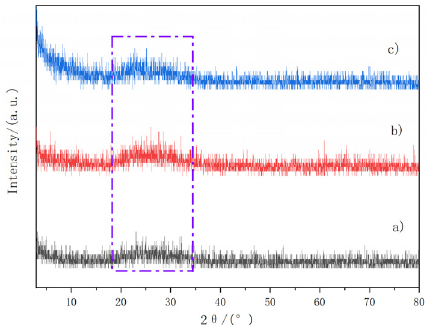
Figure 8. XRD patterns of basalt fiber before and after modification: ( a ) original fiber; ( b ) pretreated